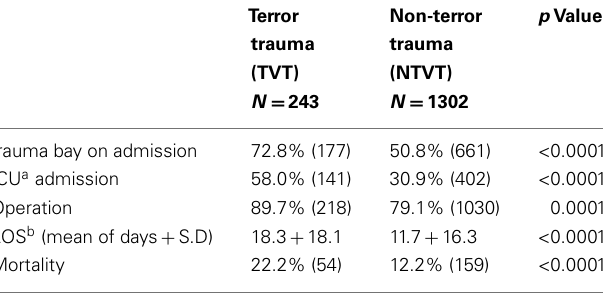
Table 2 |Vascular trauma – treatment and outcome data –TVT vs. NTVT groups (%, number)